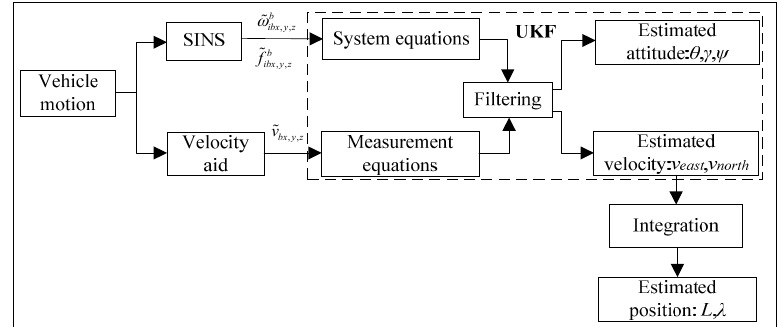
Figure 1. Diagram of the direct data fusion approach for a b -frame velocity aided SINS. b b f and are the accelerometer and gyro measurements along x , y , z -axis of Where , , , , ibx y z ibxyz body, θ , γ , ψ are the pitch, roll and heading, respectively, v east and v north are the east and north vehicle velocities with respect to the earth, respectively, L is the geographic latitude, λ is the longitude, , , bxyz are the velocity aid measurements along x , y , z -axis of body. In Figure 1, the vehicle motion changes the outputs of the inertial sensors and the aid, which are inputs of the system equations and measurement equations of the UKF, respectively. The UKF compares the b -frame velocity derived from aid outputs with the corresponding quantity estimated from the SINS, and estimates the